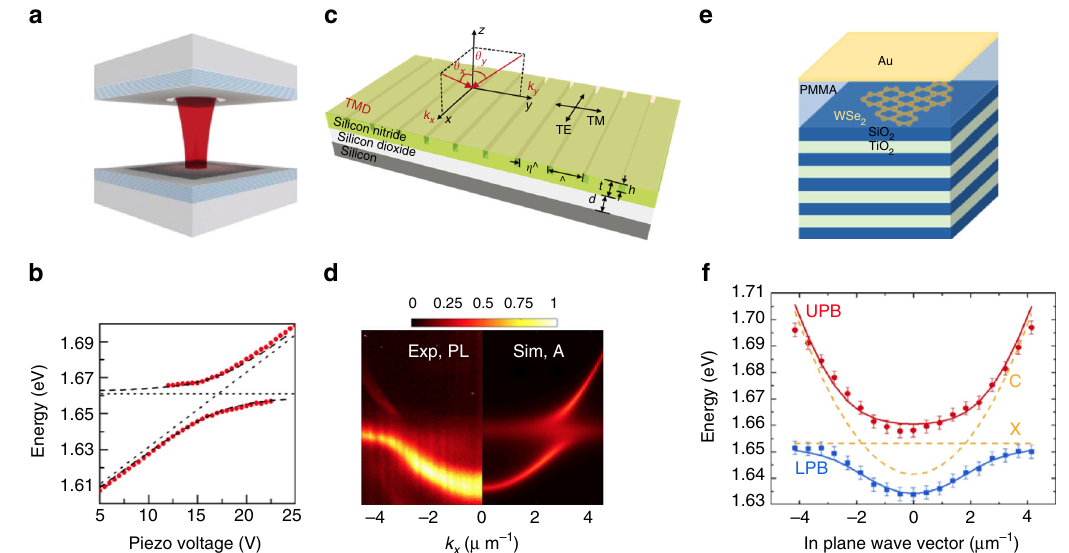
Fig. 3 Strong coupling in experiments. a Open cavity based on two separated DBR mirrors (shaded blue), the ML TMDC (dark gray) is on the bottom mirror 79 . b The distance between the mirrors is controlled by a piezo stepper motor, which allows to tune the optical cavity mode into resonance with the TMDC exciton transition, leading to an anticrossing at resonance. a , b Reproduced from Dufferwiel et al. 79 c Strong light-matter coupling conditions in lithographically de fi ned second order grating structures 82 . The TMDC ML is exfoliated directly onto the silicon nitride structure. d The anticrossing between cavity mode predicted by theory (Sim) is clearly observed in the PL measurements (Exp). c , d Reproduced from Zhang et al. 82 e Hybrid microcavity with DBR at the bottom and thin metal layer on top 85 . f The lower and upper polariton branch are observed, with error bars of the energy position given by the lineshape analysis and spectral resolution of the experiment. The position of the cavity resonance C and the exciton resonance X in the absence of coupling are marked by dashed lines. e , f Reproduced from Lundt et al.